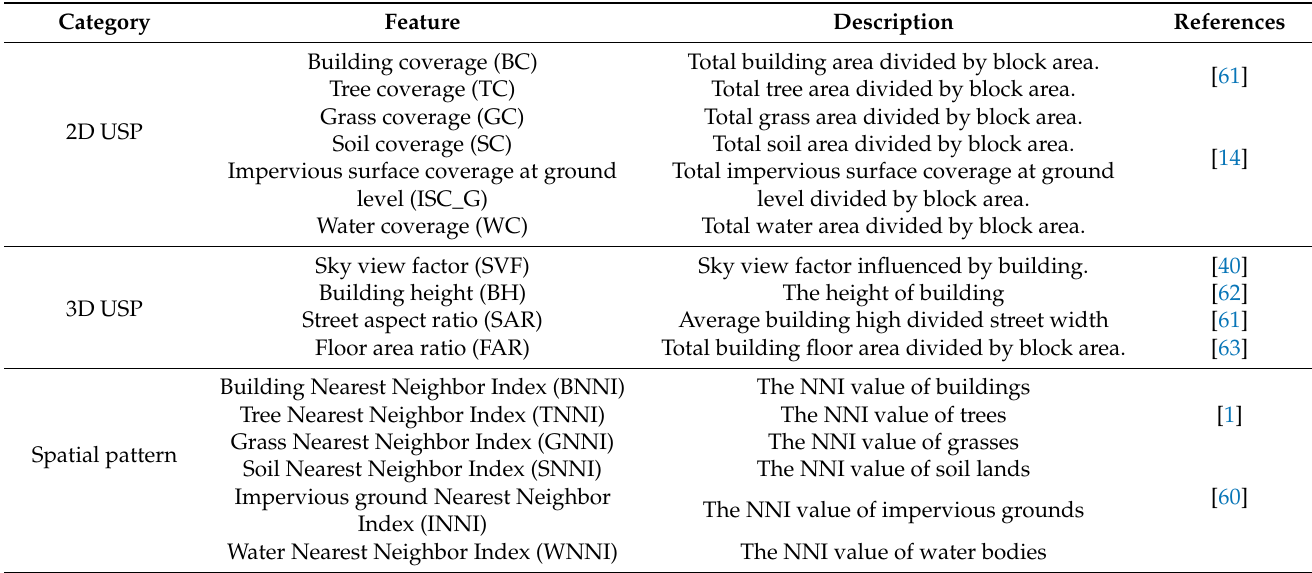
Table 4. Multi-feature extraction for UFZ mapping.